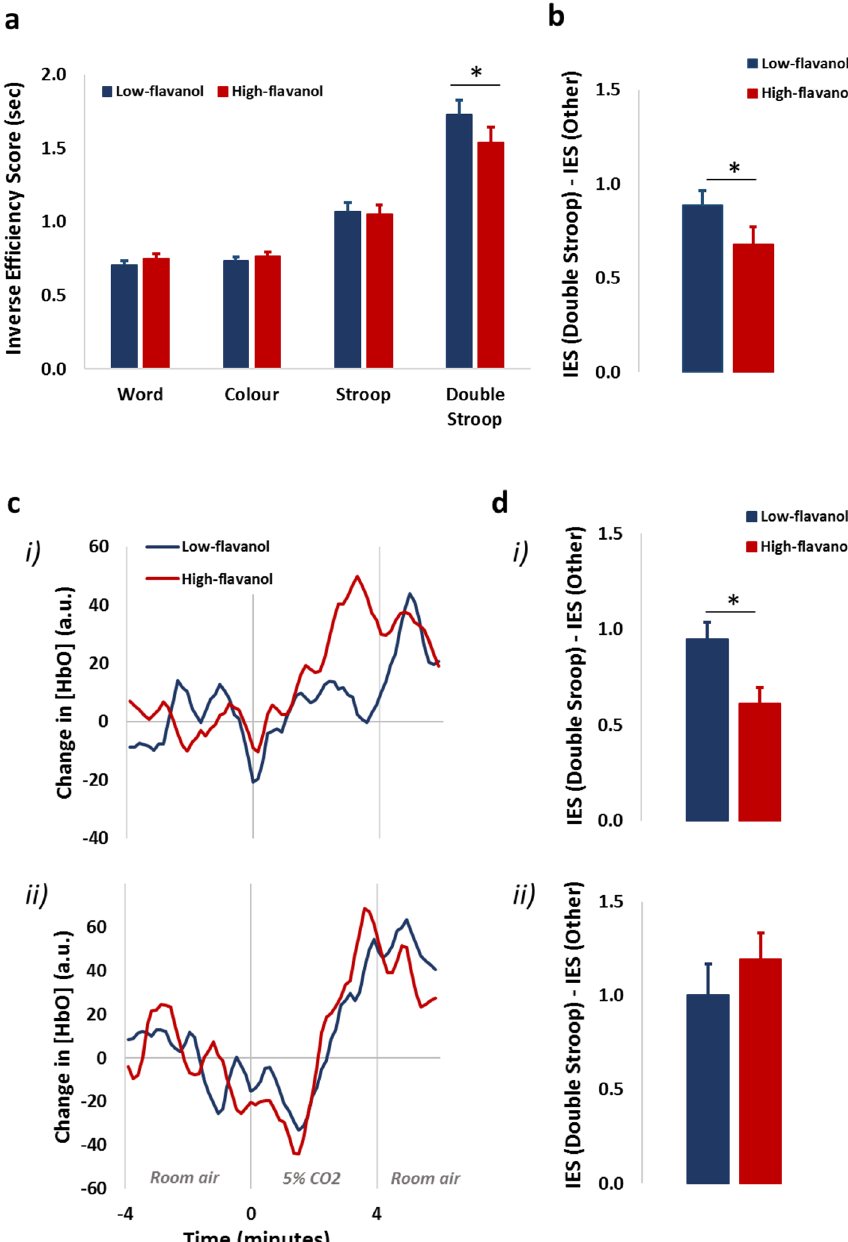
Figure 3. Cognitive performance in a modified version of the Stroop task 2 h after intake of either a low- or high-flavanol dietary intervention. Inverse efficiency score (IES) is described as reaction time/accuracy (expressed in seconds) during cognitive performance across four different conditions representing progressively harder cognitive demands ( a ). The Double-Stroop condition induces the slowest cognitive processing (higher IES) compared to the other conditions (word, colour and Stroop). The benefit of the high-flavanol intervention (lower IES) in only apparent in the Double Stroop condition, when the level of conflict is higher. The cognitive benefit of high-flavanol cocoa in the Double Stroop over and above the other cognitive tasks is significantly higher in comparison to the low-flavanol intervention (* p = 0.045) ( b ). Two sub-groups of volunteers, (i): N = 13 and (ii): N = 4, revealed distinct oxy-haemoglobin benefits from flavanols during hypercapnia ( c ); with only the sub-group (i) showing benefits from flavanols during both the hypercapnia challenge and the cognitive task ( d ). The data is presented as Mean ±